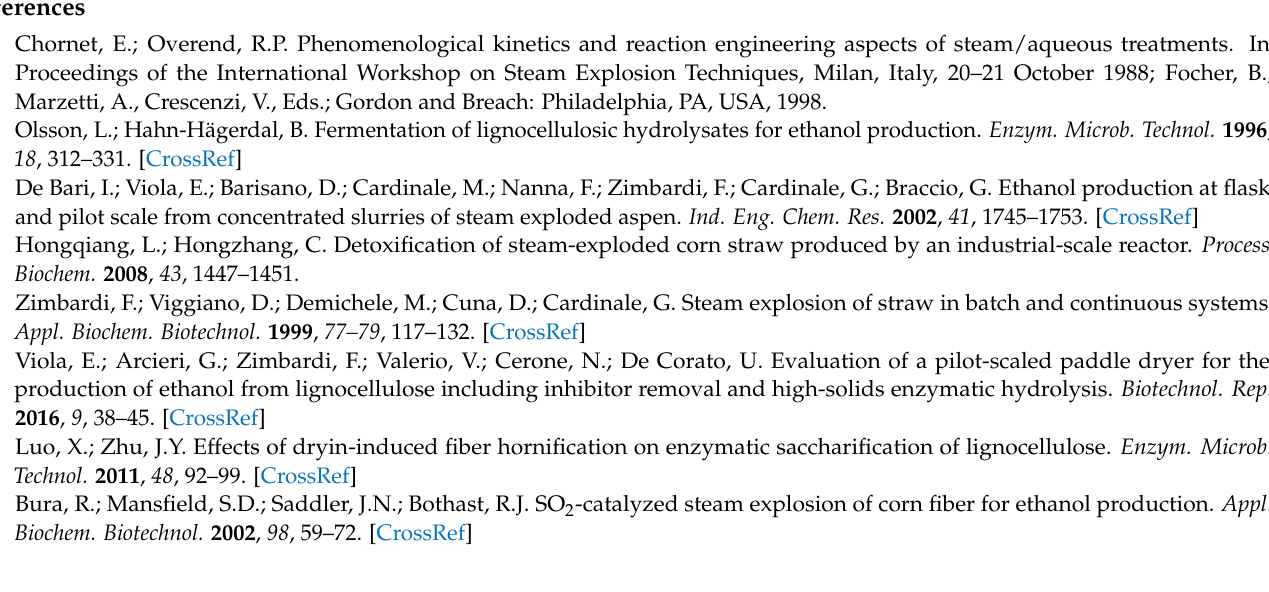
Supplementary Materials: The Tables S1–S14 and Figures S1–S4 can be downloaded at: